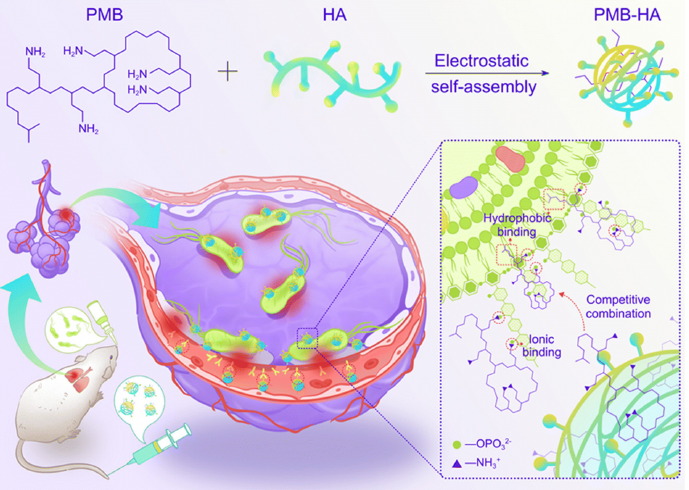
Figure 10. Schematic illustration of the construction of inflammation-targeted smart nanoparticles PMB-HA, together with the molecular mechanism of their bacteria-triggered PMB-forced-release ability to precisely kill the pneumonia bacteria with outstanding biosafety. Modified and reproduced with permission from the Royal Society of Chemistry [115]. Polymers can be used both as drug carriers and in combination with other therapeu- tic modalities to exert combined therapeutic effects. In addition to delivering antibiotics, polymers combined with antibodies, vaccines, and phages can have a dual therapeutic effect [116–119]. For example, Hussain et al. combined vancomycin-loaded nanoparticles with phage-recognized amino acid peptides, and the combined delivery of the two drugs improved the antimicrobial activity of the nanoparticles in vivo. This approach reduced the systemic dose of the drug required and minimized side effects [120]. Overall, poly- meric materials offer drug delivery strategies for the synergistic treatment of bacterial re- sistant infections.